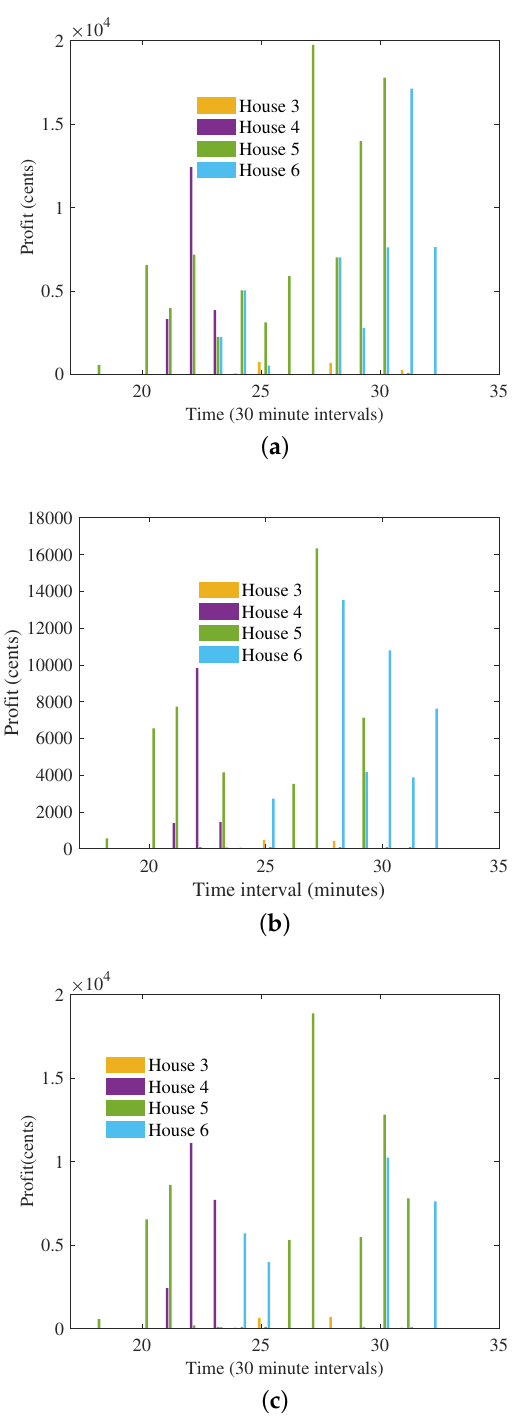
Figure 8. Hourly profit for the sellers in the microgrid with different feed-in tariff and different thresholds for energy saving at the buyers. ( a ) P f = 11 cents; ( b ) q = 0.4; ( c ) q =